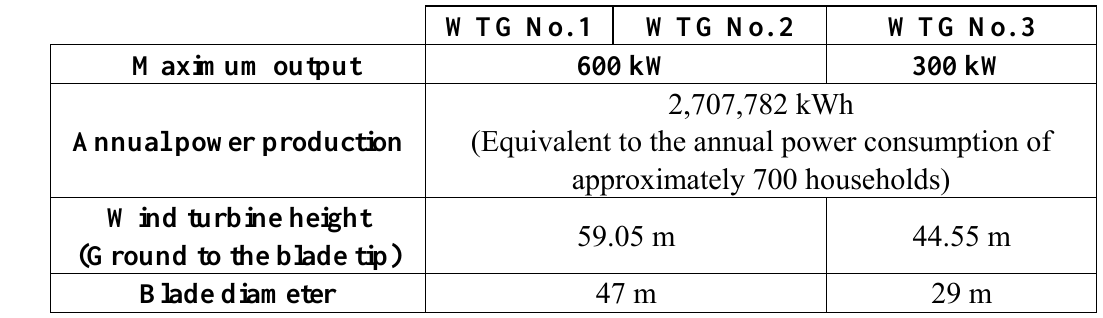
Table 4. Summary of the Asokurumagaeri wind